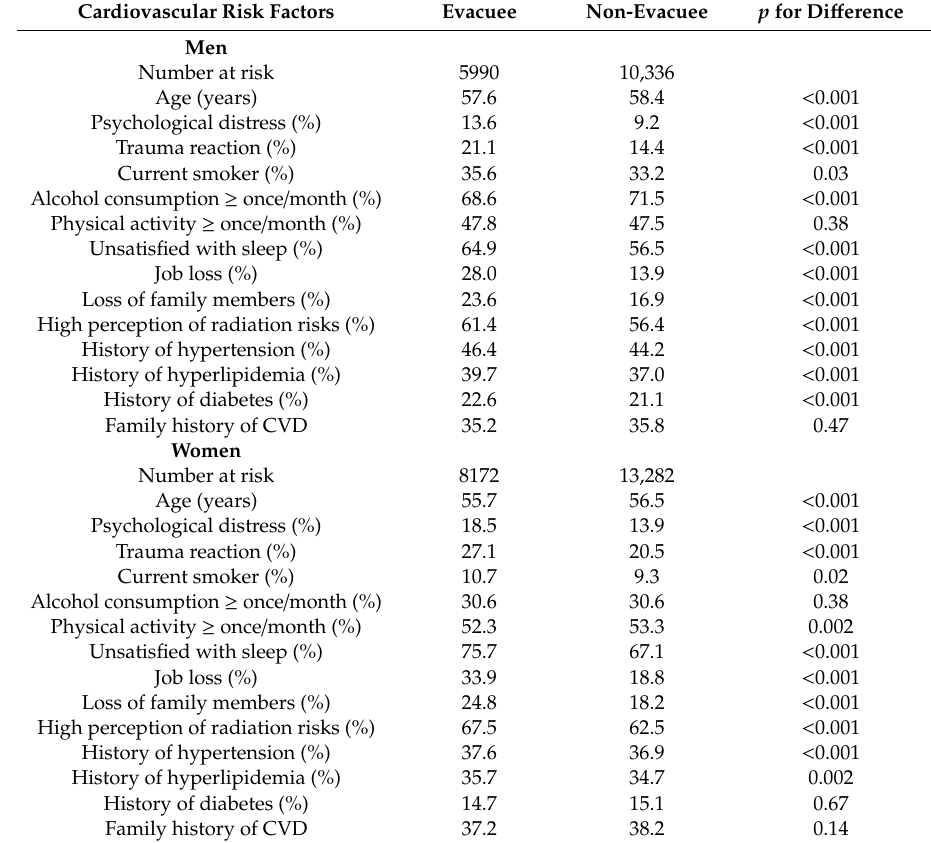
Abbreviation: CVD, cardiovascular